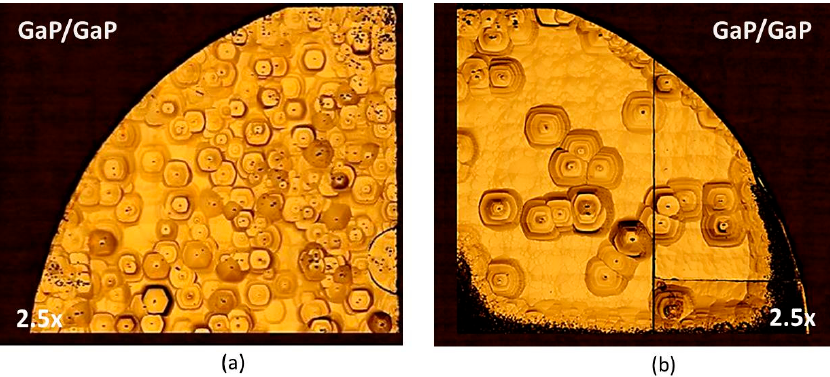
Figure 11. Nomarski microscope top layer surfaces of GaP grown on plain “on-axis” (100) GaP ( a ) and (100) GaAs ( b ) substrates. The samples are quarters of 2-inch wafers. The images are taken using stitching software at 2.5 × magnification [59]. (Reproduced from [59] with the permission of